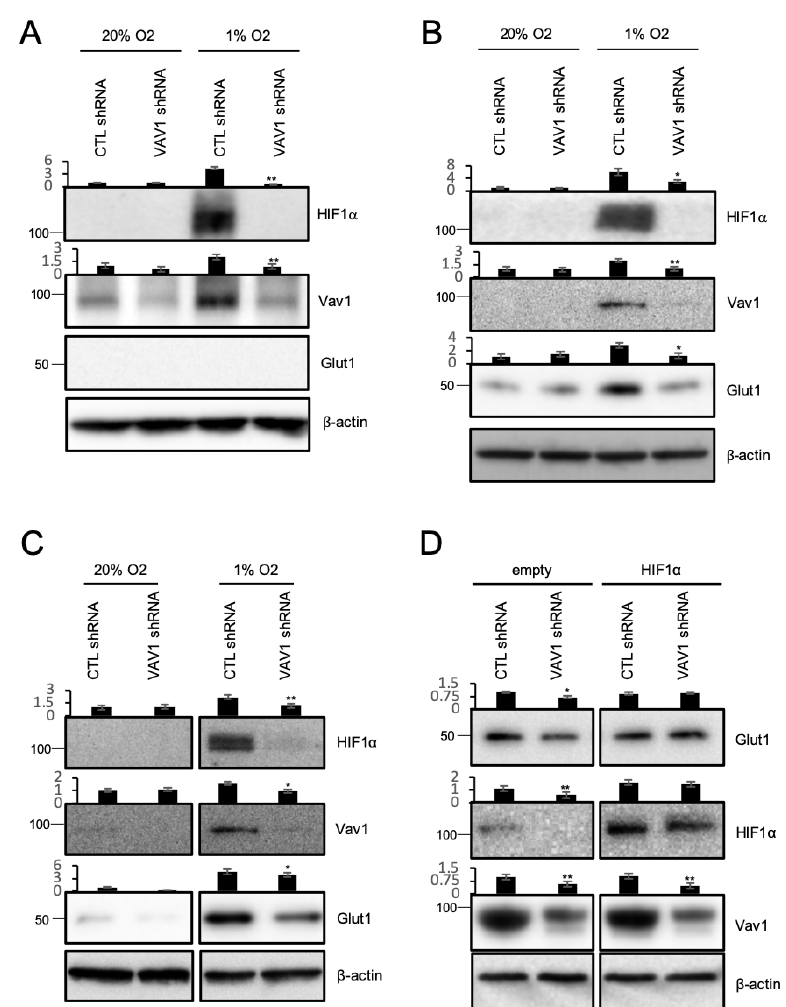
Figure 1. Vav1 regulates HIF-1α and GLUT-1 in endothelial cells. ( A ) HUVEC cells with control or Vav1 shRNA were incubated under normoxia or 1% O 2 conditions for 5 h, or ( B ) 16 h. Cells were lysed to measure HIF-1α, Vav1, and GLUT-1 levels by Western blotting. ( C ) hCMEC/d3 cells with control or Vav1 shRNA were incubated under normoxia or 1% O 2 conditions for 16 h. Cells were lysed to measure HIF-1α, Vav1, and GLUT-1 levels by Western blotting. ( D ) Control or Vav1 shRNA expressing hCMEC/d3 cells were transfected with an empty vector or HIF-1α overexpression vector. Cells were incubated under 1% O 2 conditions for 16 h and then subjected to Western blot. Each experiment was repeated three times, and representative data is selected. (* p < 0.05, ** p < 0.01, mean ± SD).